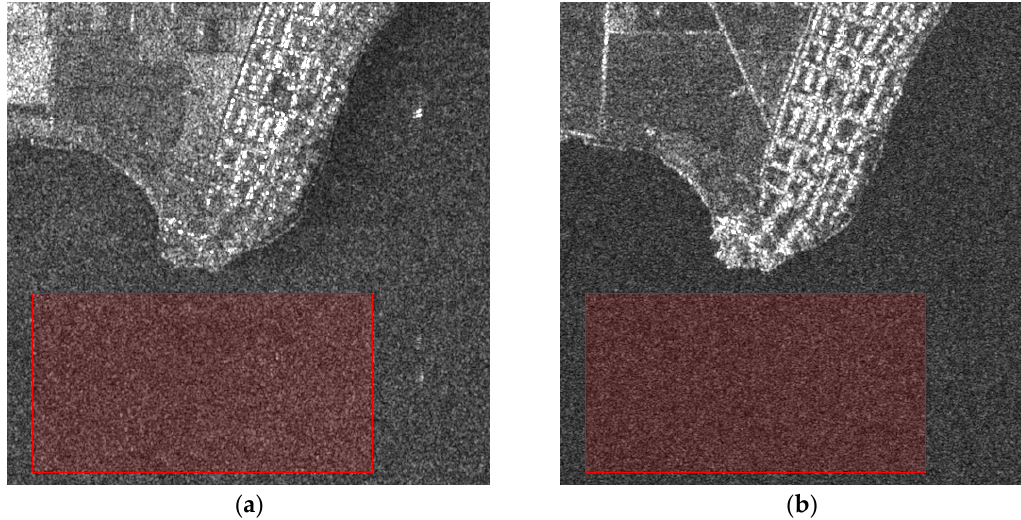
Figure 1. 512 × 512 pixel fragments of real-life Sentinel-1 SAR images with VV ( a ) and VH polarizations ( b ) with marked manually selected quasi-homogeneous regions.